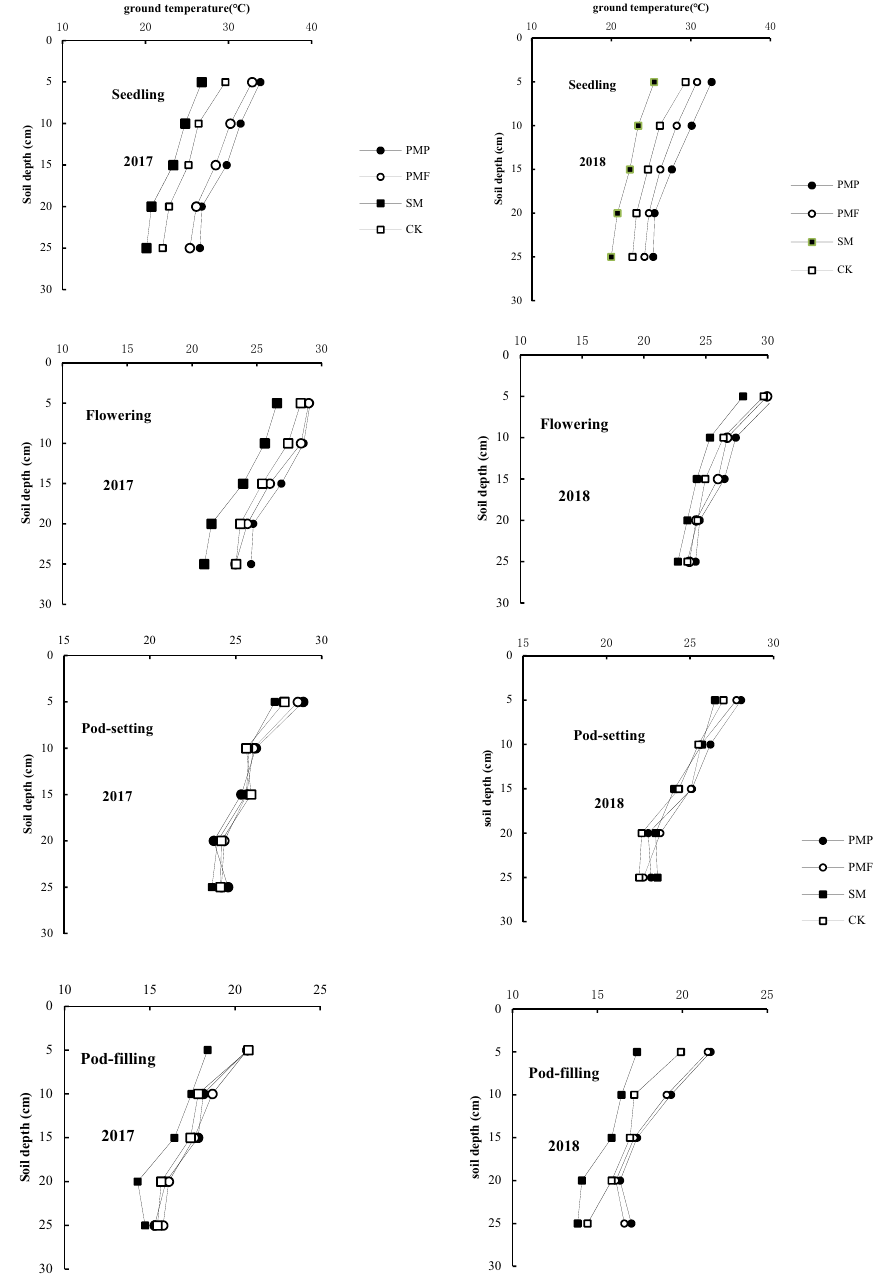
Figure 2. Soil temperature (°C) in the 0–25 cm layer during the 2017 and 2018 soybean growing seasons under different cultivation